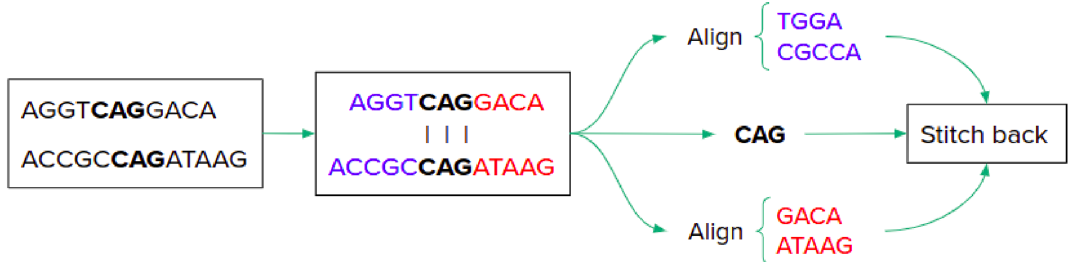
Figure 2. Illustration of longest common substring (LCS) preprocessing method. LCS provides the starting point for the alignment process. The forward and backward sub-alignment results are combined together to obtain the final alignment result.